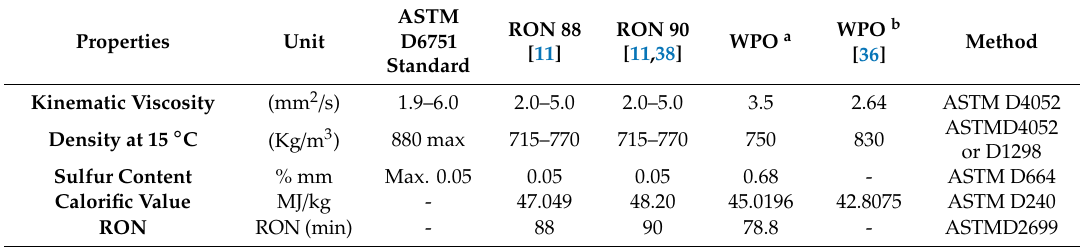
Table 3. The physicochemical properties of